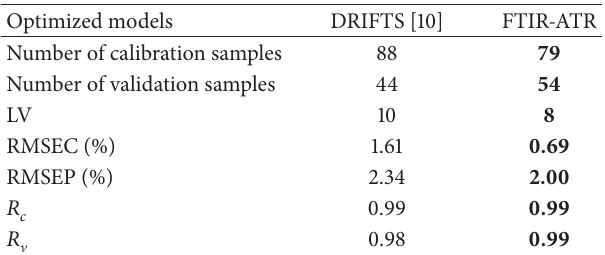
Table 5: Comparison of the performances of models based on DRIFTS and